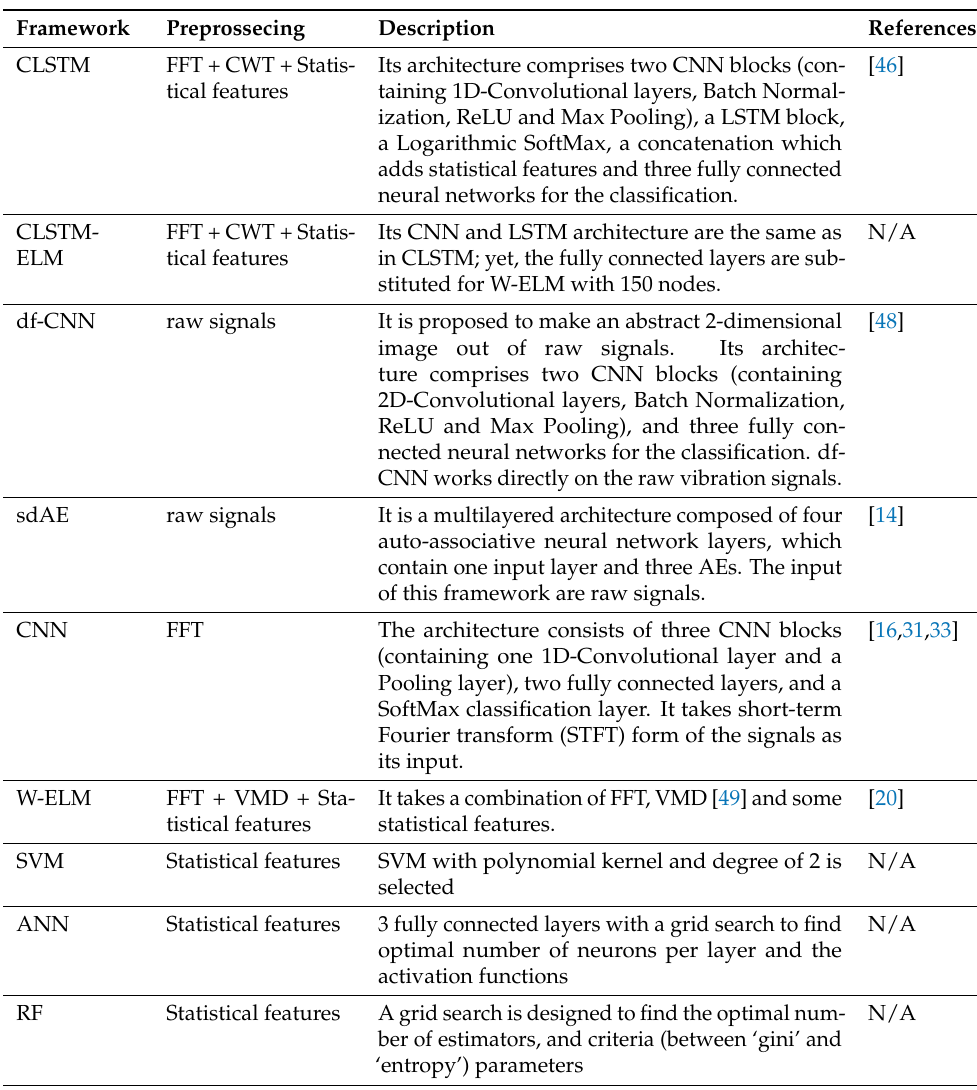
Table 3. The comparison